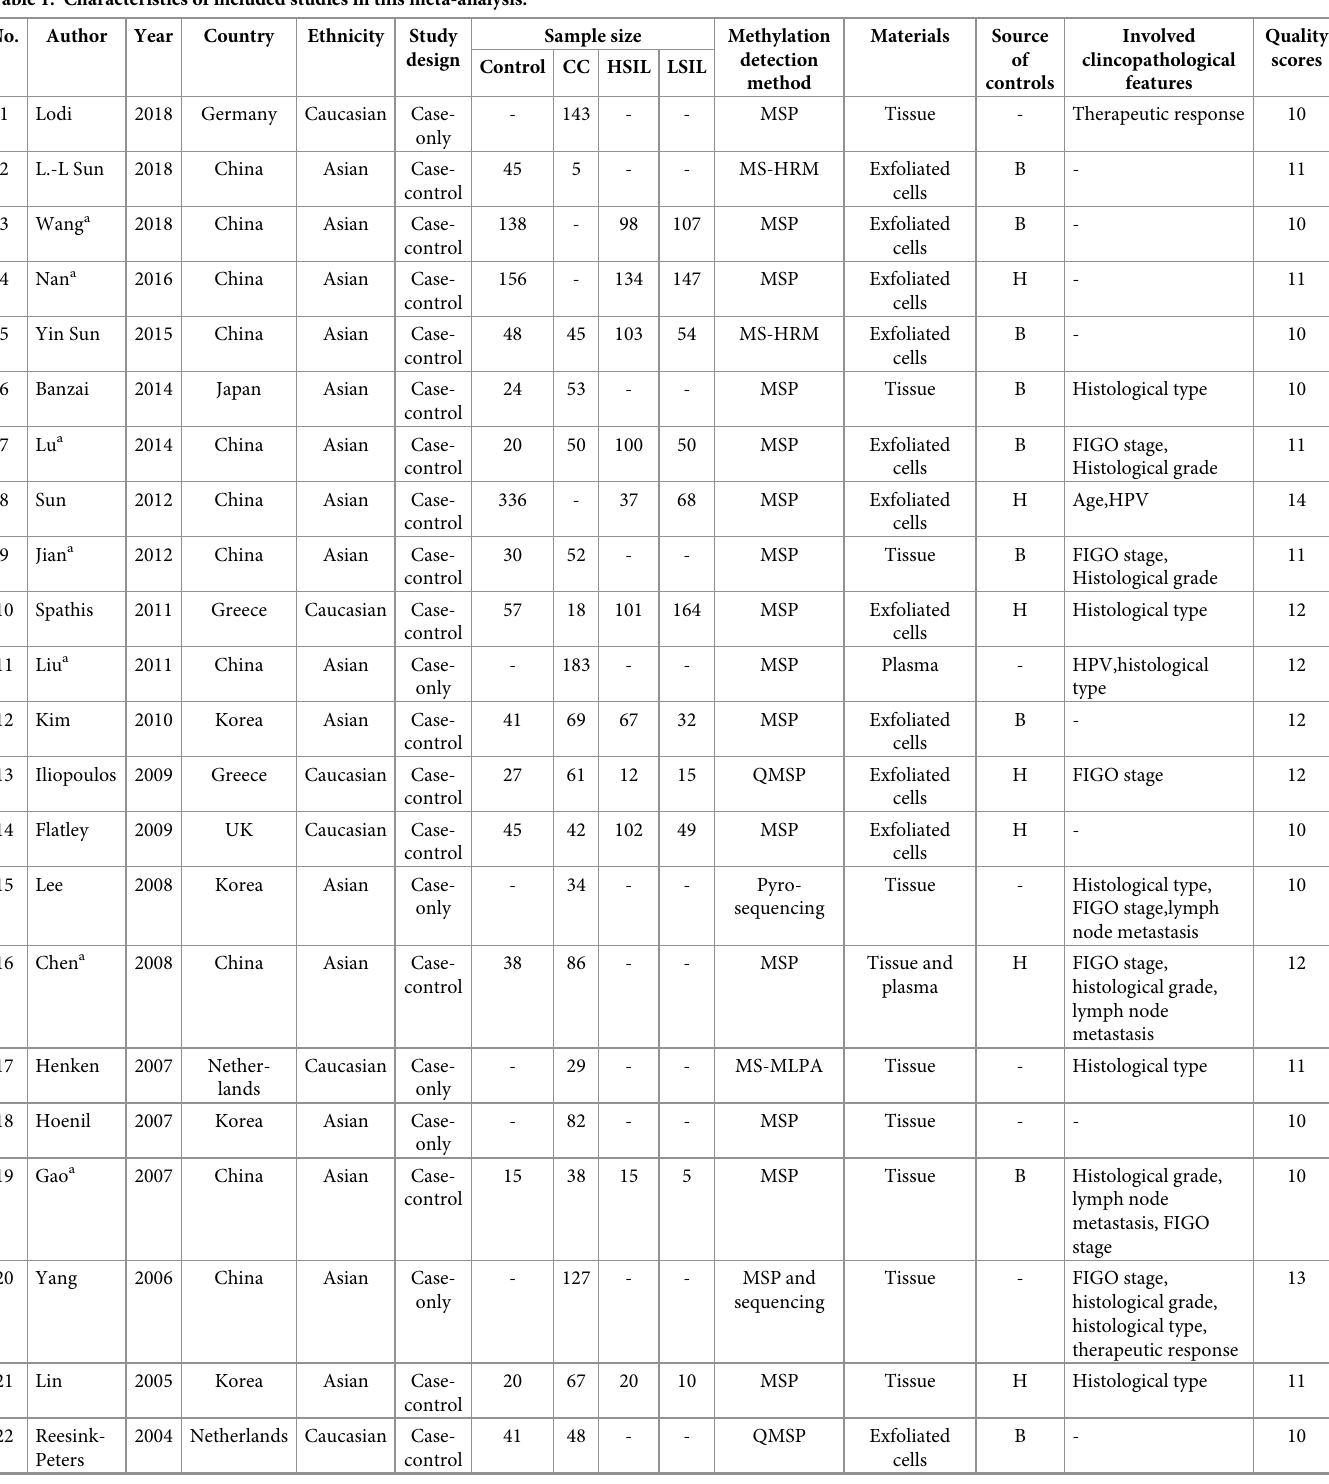
Table 1. Characteristics of included studies in this meta-analysis.